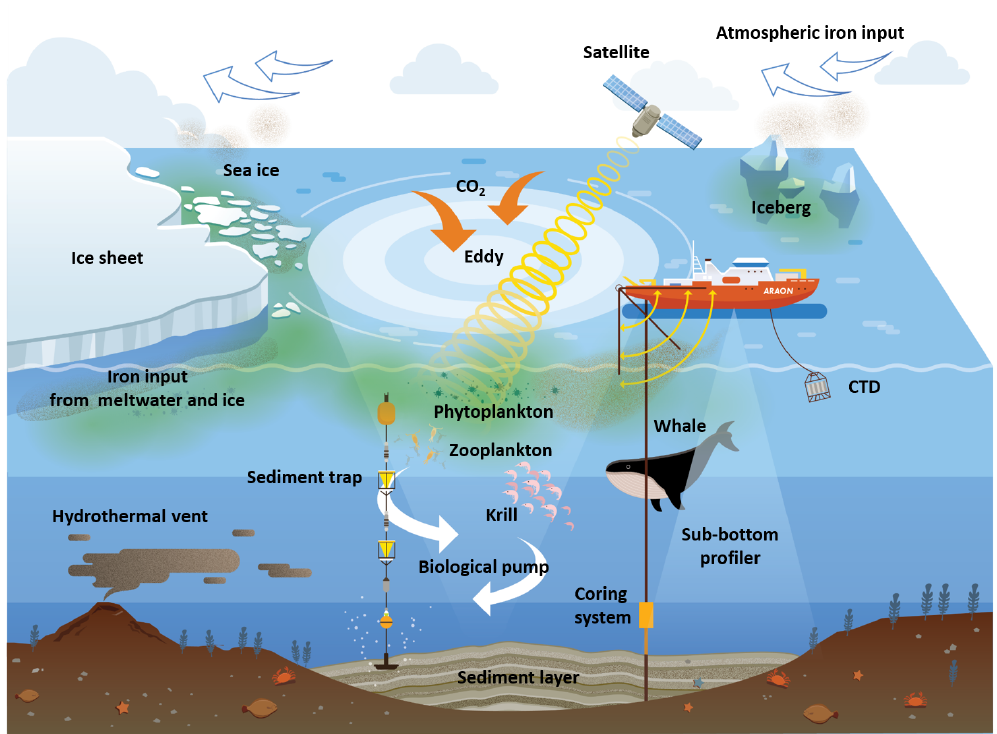
Figure 11. Schematic diagram of the Korean Iron Fertilization Experiment in the Southern Ocean (KIFES) representing the experiment target site (eddy structure) and survey methods (underway sampling systems, multiple sediment traps, sub-bottom profilers, sediment coring systems, and satellite